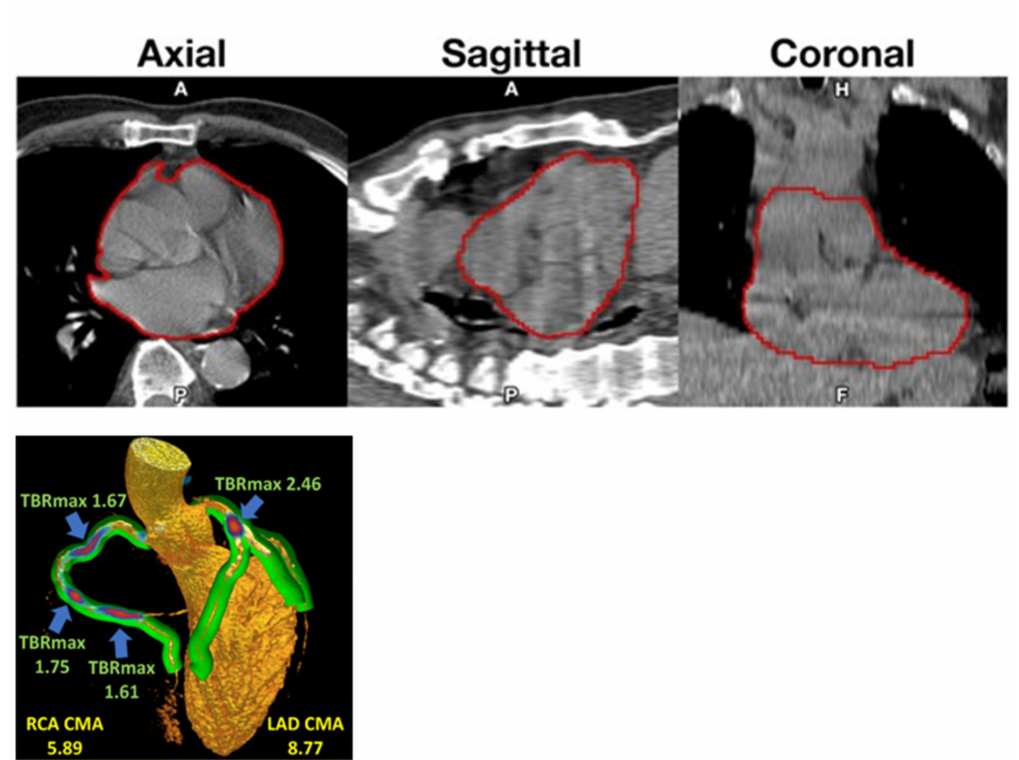
Figure 2. ( Top ): Volume of interest (VOI) capturing a representative heart. VOIs were thresholded to exclude voxels under − 50 HU before being superimposed onto corresponding PET images (reproduced with permission from reference [4]). ( Left ): three-dimensional (3D) rendering of coronary CT angiography with superimposed tubular whole-vessel volumes of interest (light green) employed for evaluation of NaF uptake (blue and red). Despite the relatively lower TBRmax due to multiple foci of increased NaF activity, the coronary microcalcification activity (CMA) in the right coronary artery (RCA) is only moderately lower than in the left anterior descending (LAD) coronary artery, which presented with a very high TBRmax (with permission from reference